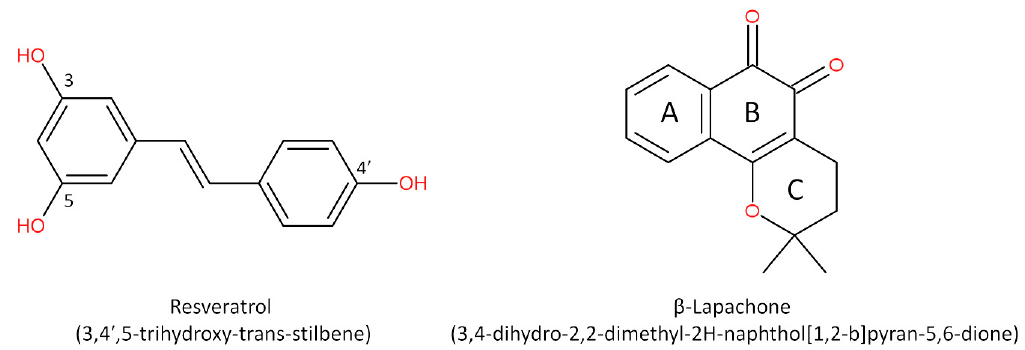
Figure 1. Structures of resveratrol and β -lapachone.